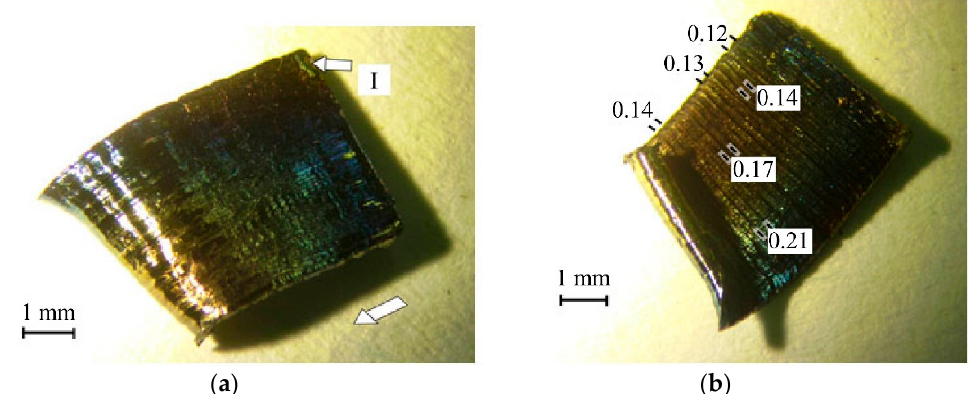
Figure 15. Chips generated during dry turning (demonstrating varying colors): outside ( a ); inside ( b ).